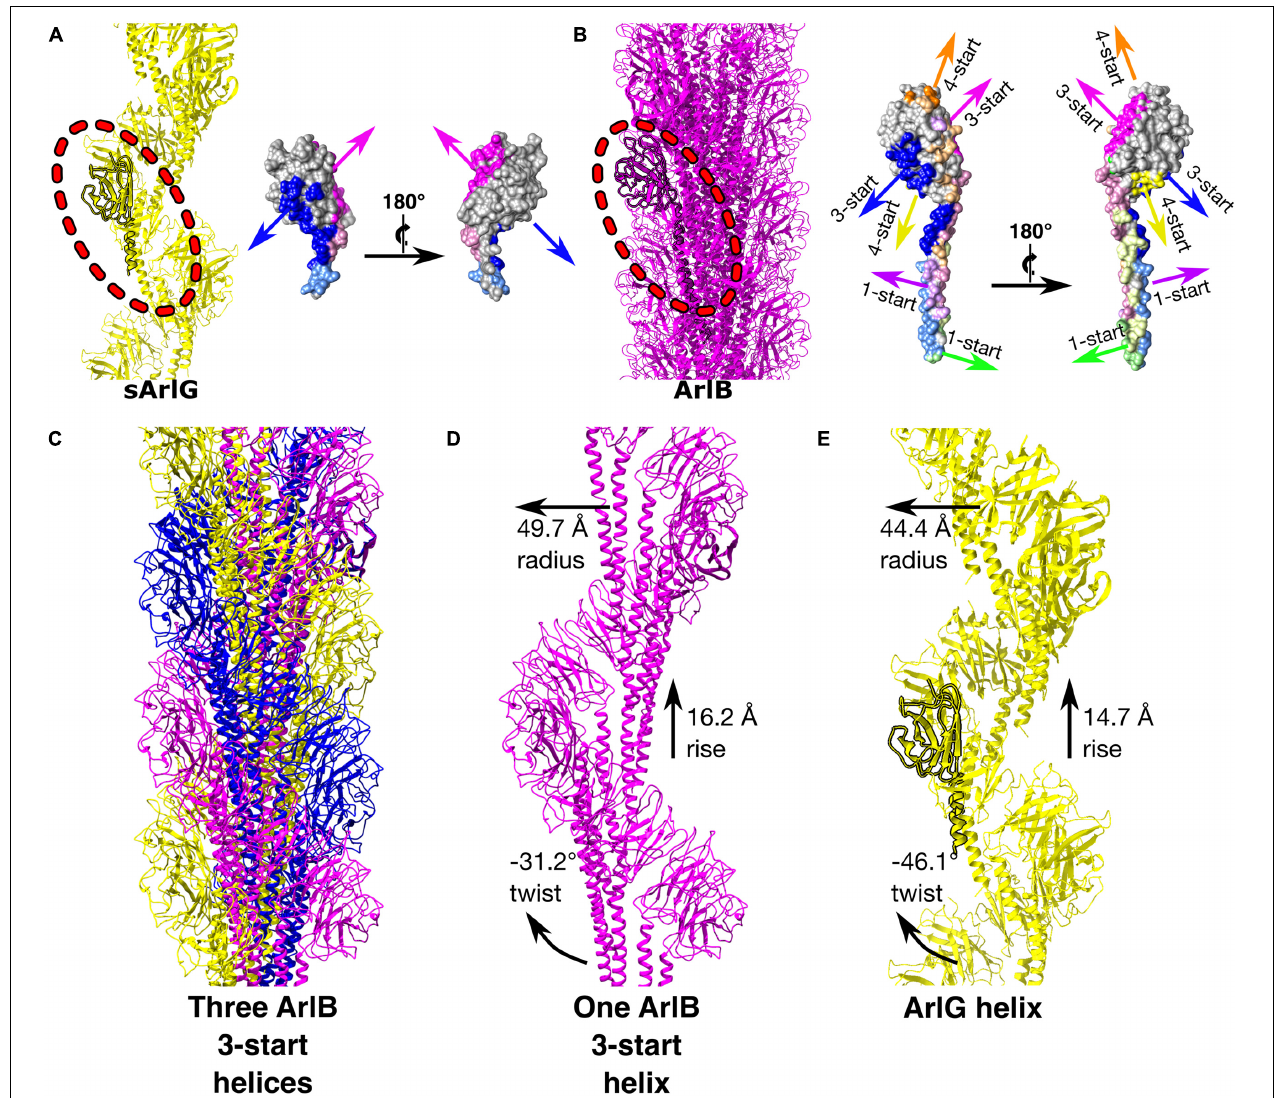
FIGURE 4 | sArlG forms a helical filament with a different quaternary structure to the ArlB filament yet using a subset of the interactions used by ArlB. Comparison of the quaternary structures of the P. furiosus sArlG and ArlB filaments. (A) Left: Model of the sArlG filament (yellow) with a single protomer highlighted (outline). Right: two views of intersubunit sArlG interactions mapped onto the surface of a single protomer; blue represents interactions with the preceding protomer while pink represents interactions with the next protomer. Full colors represent interactions to the other subunit’s archaellin domain while pastels represent interactions to the N-terminal α -helix tail. (B) Left: Model of the ArlB filament from PDB 5O4U (purple) with a single protomer highlighted (outline). Six colors represent preceding and next protomers in the 1-start, 3-start, and 4-start helices of the filament. The 3-start helix interactions of ArlB (blue and pink) correspond to the intersubunit interactions of sArlG. (C) Illustration of the three 3-start ArlB helices in yellow, magenta, and blue. (D) The interactions and helical parameters of a single extracted 3-start helix of ArlB resembles (E) the sArlG